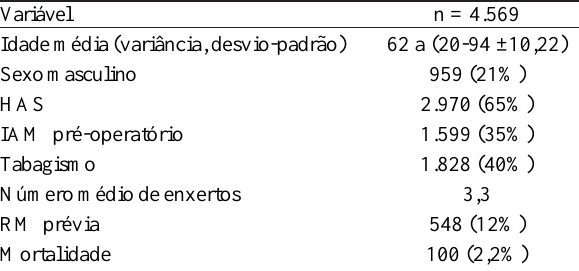
Tabela 1. Características demográficas da amostra